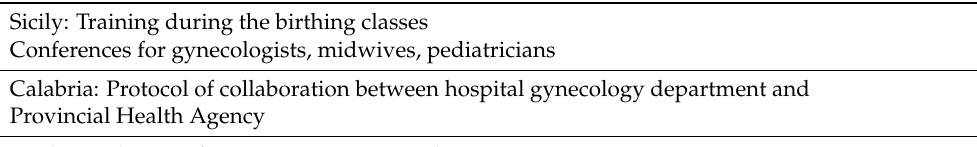
Table 3. Local initiatives to promote the immunization of pregnant women in some Italian regions. Sicily: Training during the birthing